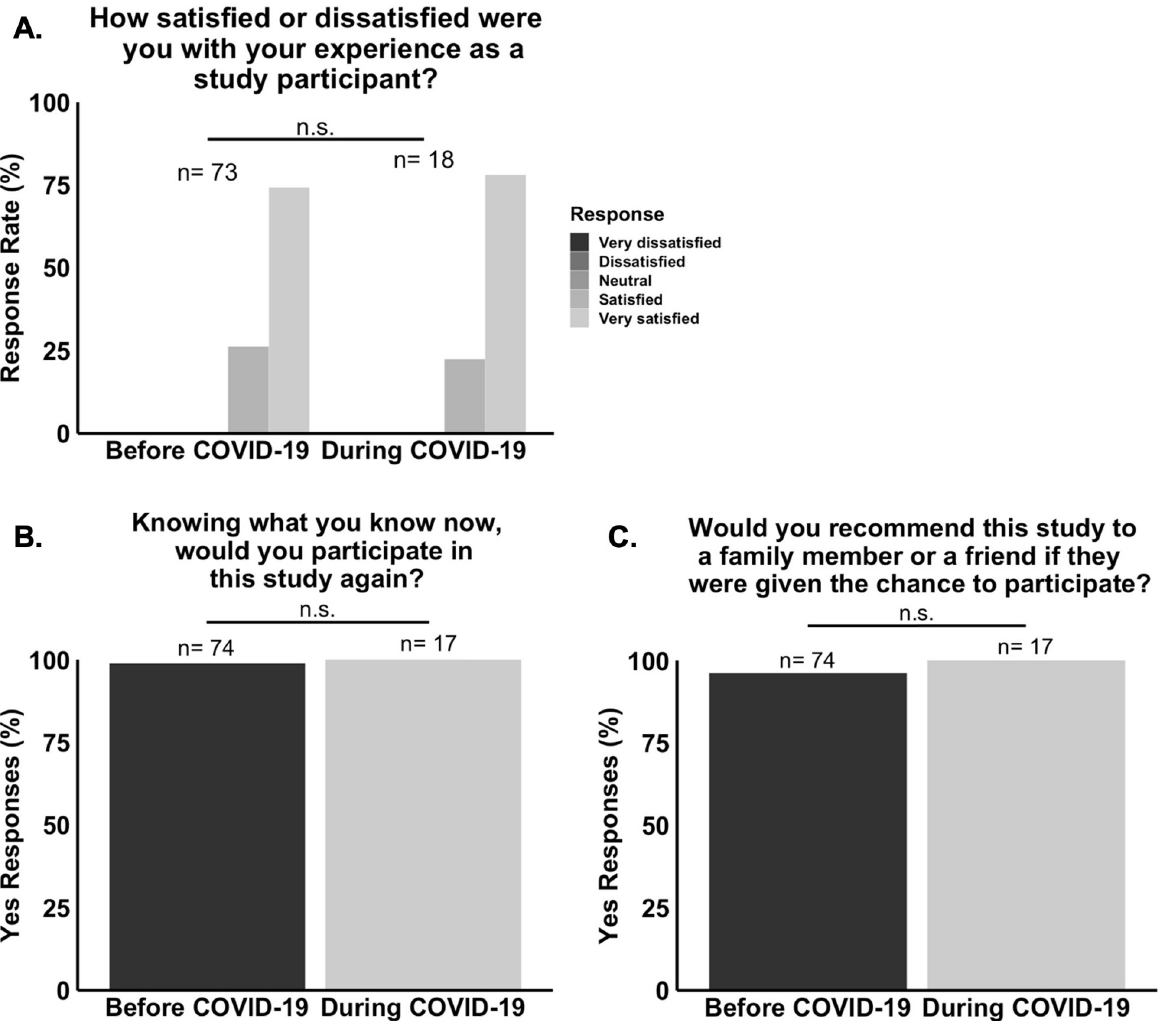
Fig 6. Responses to the trial satisfaction survey questions did not differ significantly between the “During COVID-19” and “Before and COVID-19” groups of the NO/AKI trial. (A.) There was no statistically significant difference in the median response to question 11 (n = 91, P = 0.75) between the two time frames. (B.) There was no statistically significant association between responses to question 12 (n = 91, P = 1) or (C.) question 13 (n = 91, P = 1) and time